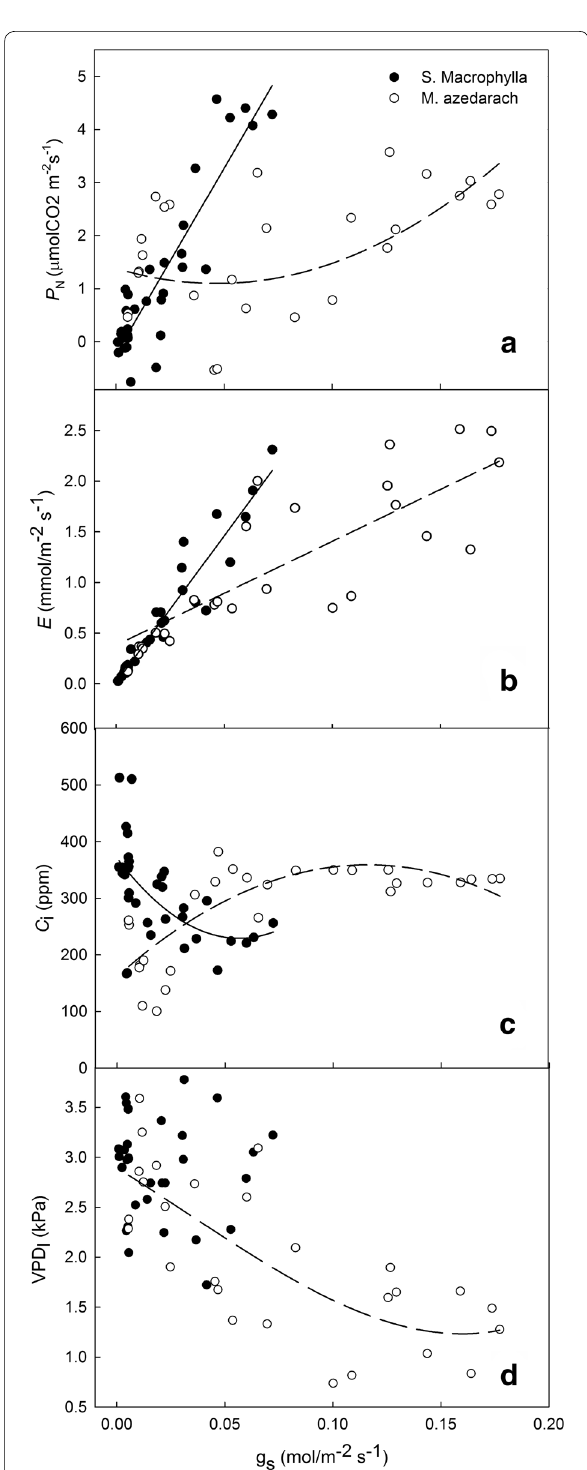
Fig. 4 Relationship between stomatal conductance ( g s ) and other gas exchange variables in Swietenia macrophylla and Melia azedarach ( N 36). Net photosynthetic rate ( P N ; a ), transpiration ( E ; b ), intercel‑ = lular CO 2 concentration ( C i ; c ), and vapor pressure deficit (VPD l ; d